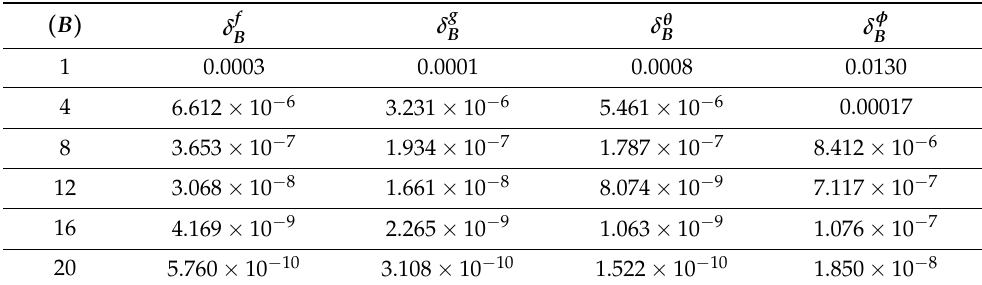
Table 1. Computation of averaged squared residuals errors of velocity, temperature, and concentra- tion